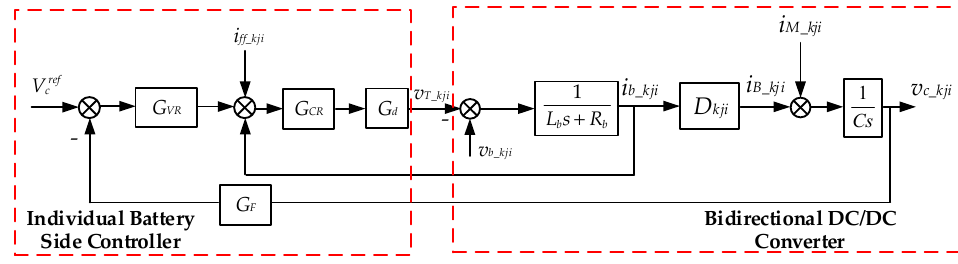
Figure 12. Simplified control block diagram of the individual DC/DC converter.